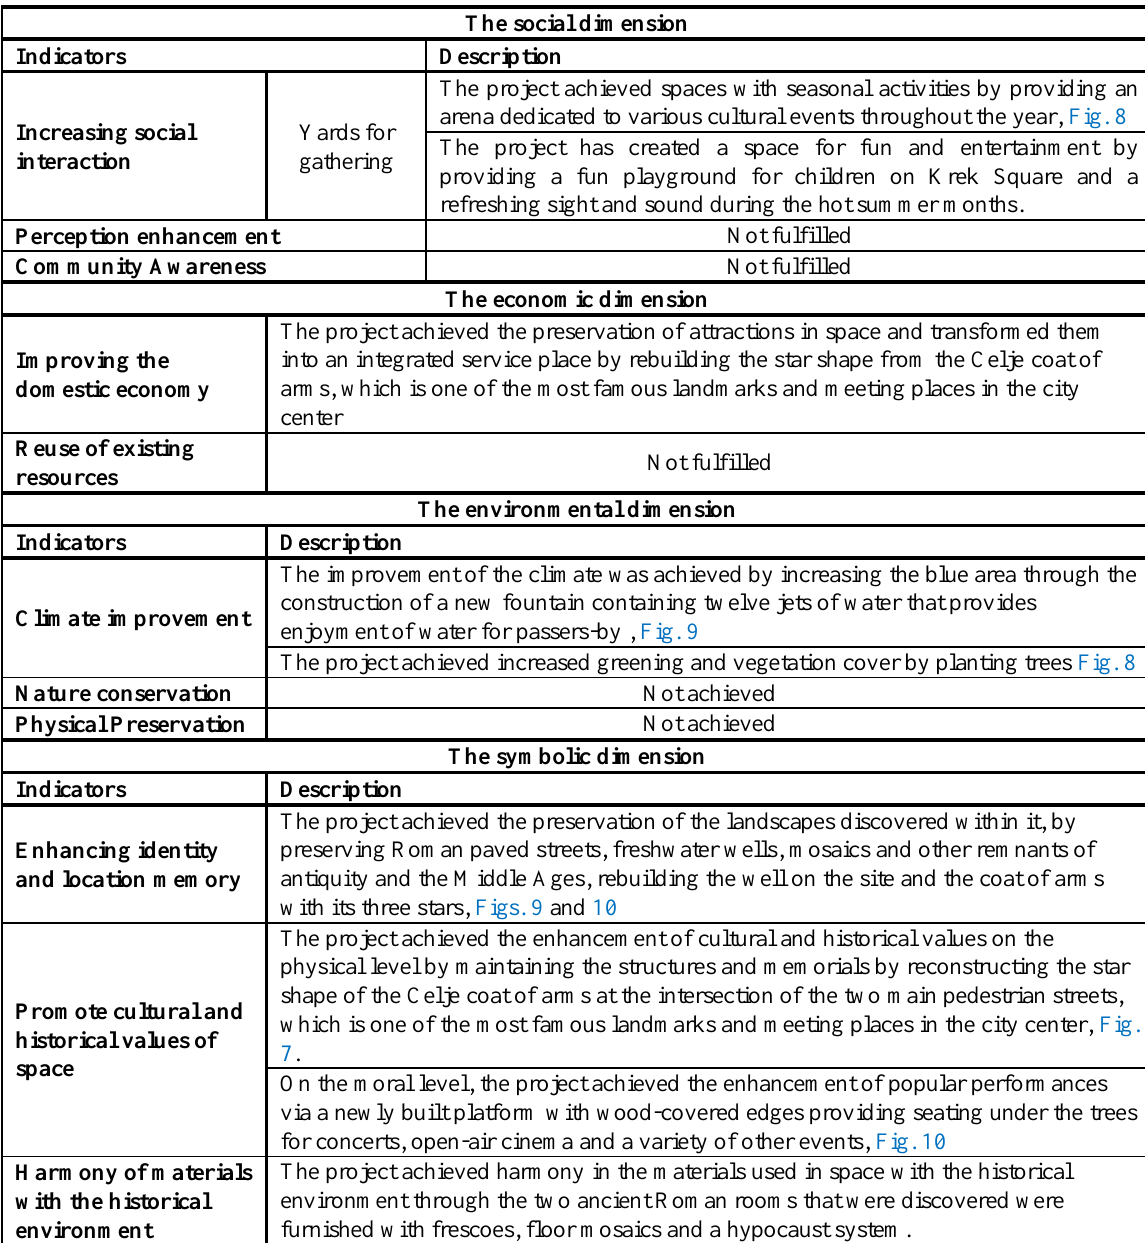
Table 3. The form of measuring verification values for the dimensions of activating landscapes second case, (prepared by the